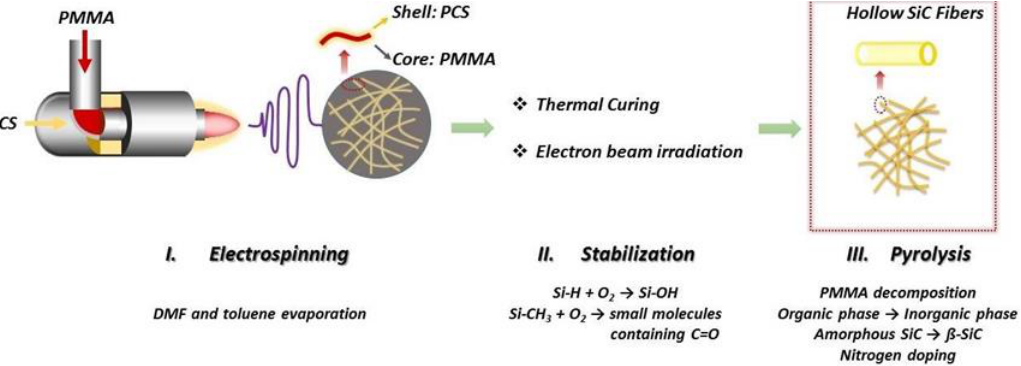
Figure 9. Fabrication procedure illustration of N-doped hollow SiC fibrous mats (Reprinted with permission from Ref. [69]. 2013 Royal Society of Chemistry).